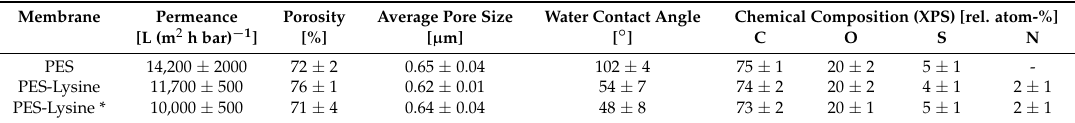
Table 1. Characteristics of pristine PES and PES–Lysine membrane.